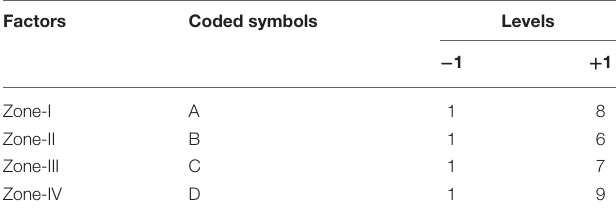
TABLE 6 | The design approach for determining the optimization of four sampling zones in the abundance of C. perfringens in Box–Behnken Design (BBD). Factors Coded symbols Levels − 1 + 1